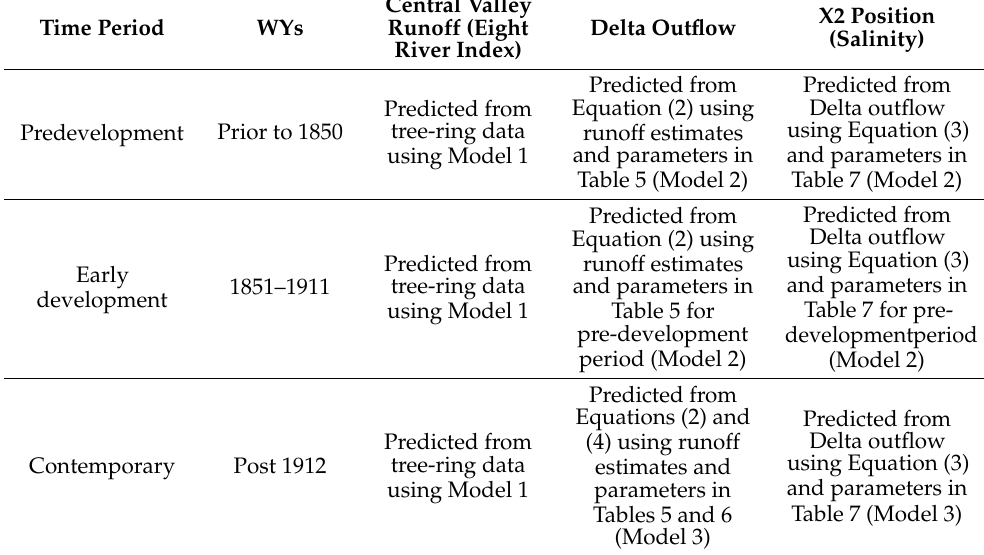
Table 2. Summary of modeled time periods and key